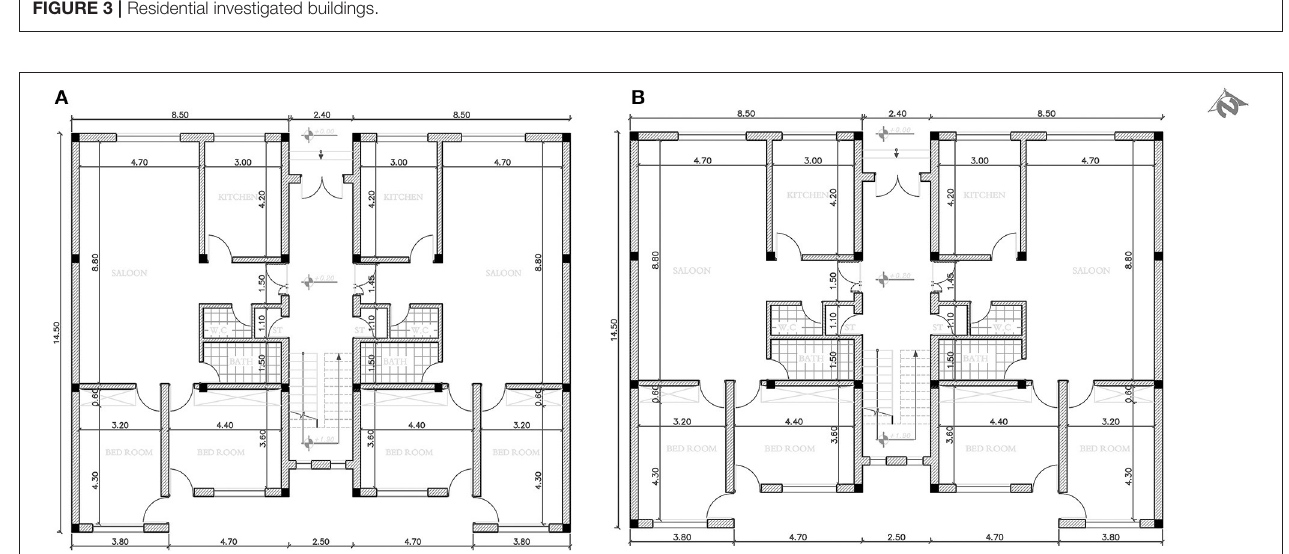
FIGURE 3 | Residential investigated buildings.